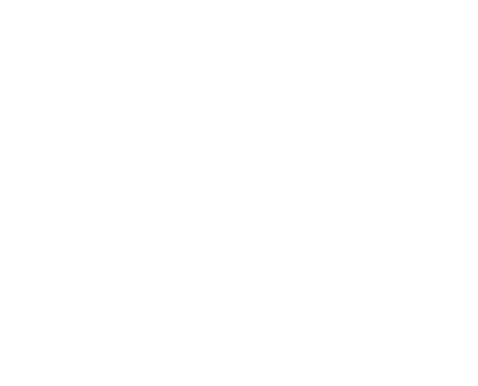
Figure 1. PRESS changes with the principal